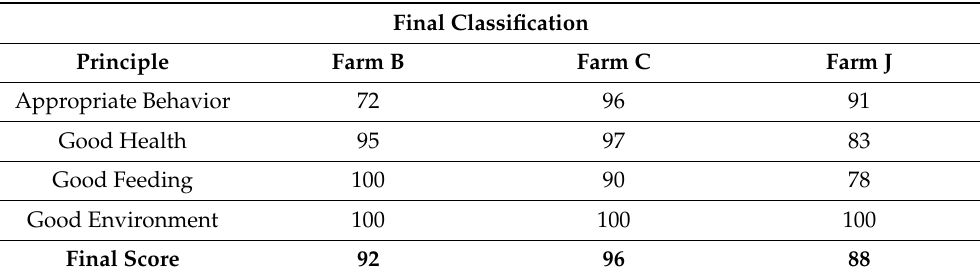
Table 13. Final classification of farms accordingly to the four principles.